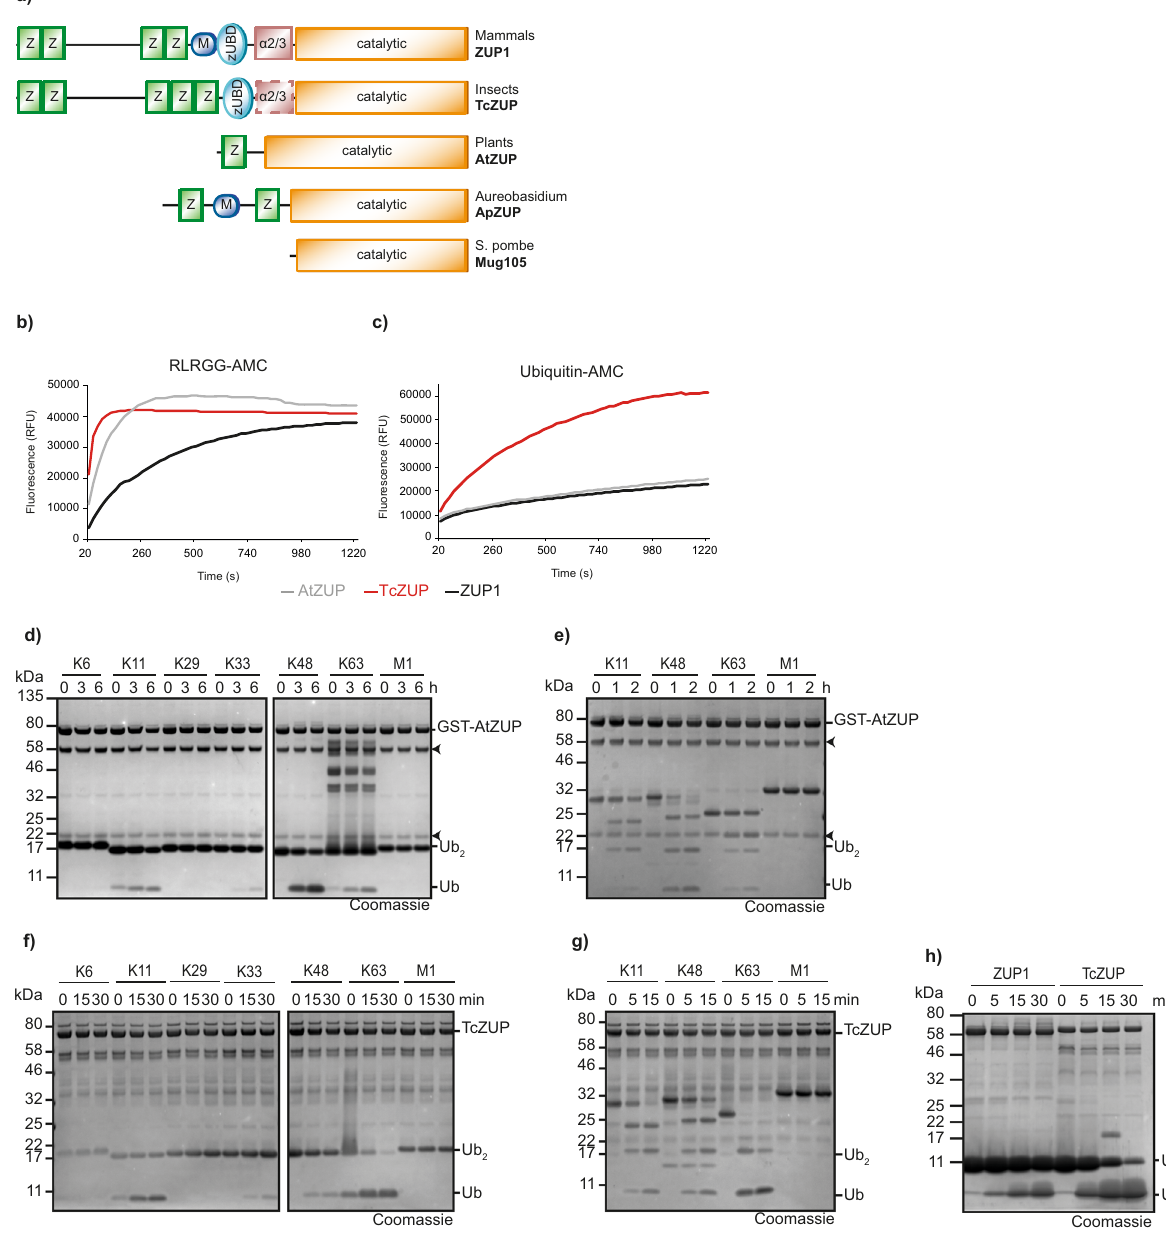
Fig. 2 Selectivity within the ZUFSP family. a Schematic representation of the domain architecture of ZUP1 homologs from different species. UBZ-like zinc fi ngers (Z), MIU domains (M), ZUFSP ubiquitin-binding domains (zUBD), α -2/3 region, and the catalytic domain are shown as boxes. The position of the non-conserved α -2/3 region in insect ZUP is indicated by a dashed line. b , c Activity of ZUP homologs from A. thaliana (AtZUP) and T. castaneum (TcZUP) against RLRGG-AMC ( b ) and ubiquitin-AMC ( c ). The RFU values shown are the means of triplicates. d , e Linkage speci fi city analysis of AtZUP. A panel of di-ubiquitin ( d ) or tetra-ubiquitin ( e ) chains was treated with GST-AtZUP for the indicated time points. Black arrowheads mark the N- and C-terminal fragments of AtZUP (Supplementary Fig. 5c). f , g Linkage speci fi city analysis of TcZUP. A panel of di-ubiquitin ( f ) or tetra-ubiquitin ( g ) chains was treated with TcZUP for the indicated time points. h Comparison of ZUP1 and TcZUP hydrolysis rate. K63-linked di-ubiquitin was treated with ZUP1 or TcZUP for the indicated time points. Source data are provided as a Source Data fi crystal lattice. This idea is supported by experiments using a double While in the ZUP1 structure the MIU domain is rigidly mutation of Glu-248 and Ser-249, two residues involved in the connected to the zUBD by being part of an uninterrupted α -helix 5 , unconventional ubiquitin contact of the UBZ domain (Supplemen- the UBZ of TcZUP is connected to the zUBD by a fl exible linker tary Fig. 3b). As shown in Supplementary Fig. 3c, the chain-cleaving (Fig. 3a, c). In the crystal structure of TcZUP, the UBZ folds back activity of the E248A/S249A mutant of the catalytic TcZUP and contacts the S1-ubiquitin moiety, which is already bound by the fragment is indistinguishable from that of the wild-type form. zUBD domain (Fig. 3a). However, this contact does not engage the The zUBD surface that recognizes the Ile-44 patch of the canonical ubiquitin-interaction surface of UBZ domains 9 , suggest- ing that it might be non-physiological and possibly caused by the outgoing (S1) ubiquitin is highly conserved between ZUP1 and